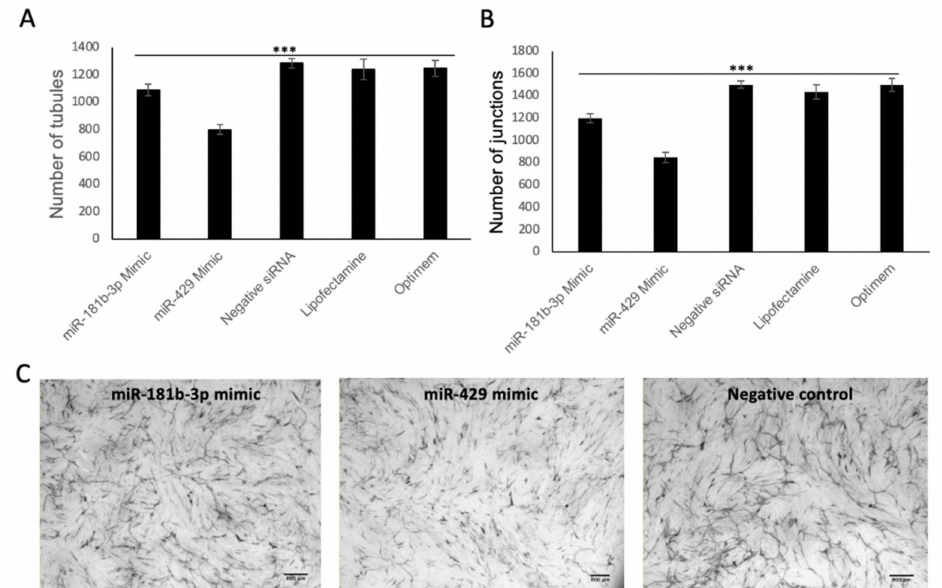
Figure 4. Endothelial–fibroblast co-cultures. ( A ) Number of tubules formed by HUVECs grown in co-culture with fibroblasts after transfection of miR-429 or miR-181b-3p mimics. The numbers represent the mean from 4 separate experiments. An ANOVA test was used to look for significance between groups. *** = p < 0.001. Tukey’s test was used to compare groups, which demonstrated that number of tubules was significantly reduced in both mimic groups in comparison to the negative siRNA group, suggesting that miR-429 and miR-181-3p reduce angiogenesis. ( B ) Number of junctions formed by HUVECs grown in co-culture with fibroblasts after transfection of miR-429 or miR-181b-3p mimics. The numbers represent the mean from 4 separate experiments. An ANOVA test was used to look for significance between groups. *** = p < 0.001. Tukey’s test was used to compare groups, which demonstrated that number of junctions was significantly reduced in both mimic groups in comparison to the negative siRNA group, suggesting that miR-429 and miR-181-3p reduce angiogenesis. ( C ) Representative images from these experiments are shown. Branching structures of HUVECs are seen, which are endothelial tubules. A reduction in tubule formation is seen in endothelial cells transfected with miR-181b-3p and miR-429 in comparison to transfection with the negative control. Scale bars represent 800 µ